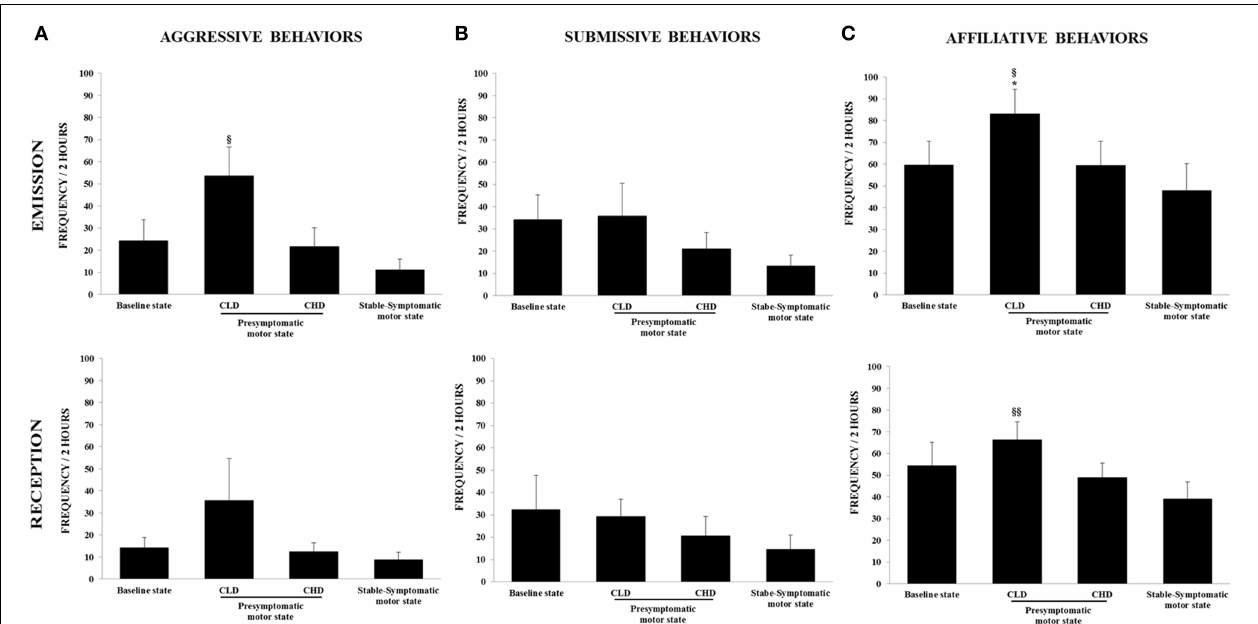
FIGURE 4 | Evolutionofsocialbehaviorsfrombaselinetopresymptomatic and symptomatic motor states within the social group ( n = 6). (A) Aggressive behaviors were recorded in terms of emission and reception using the focal animal sampling method for each monkey. Values were means ± SD ( n = 6). § p < 0 . 05: CLD-presymptomatic motor state vs. stable-symptomatic motor state (ANOVA and post-hoc test). (B) Submissive behaviors were